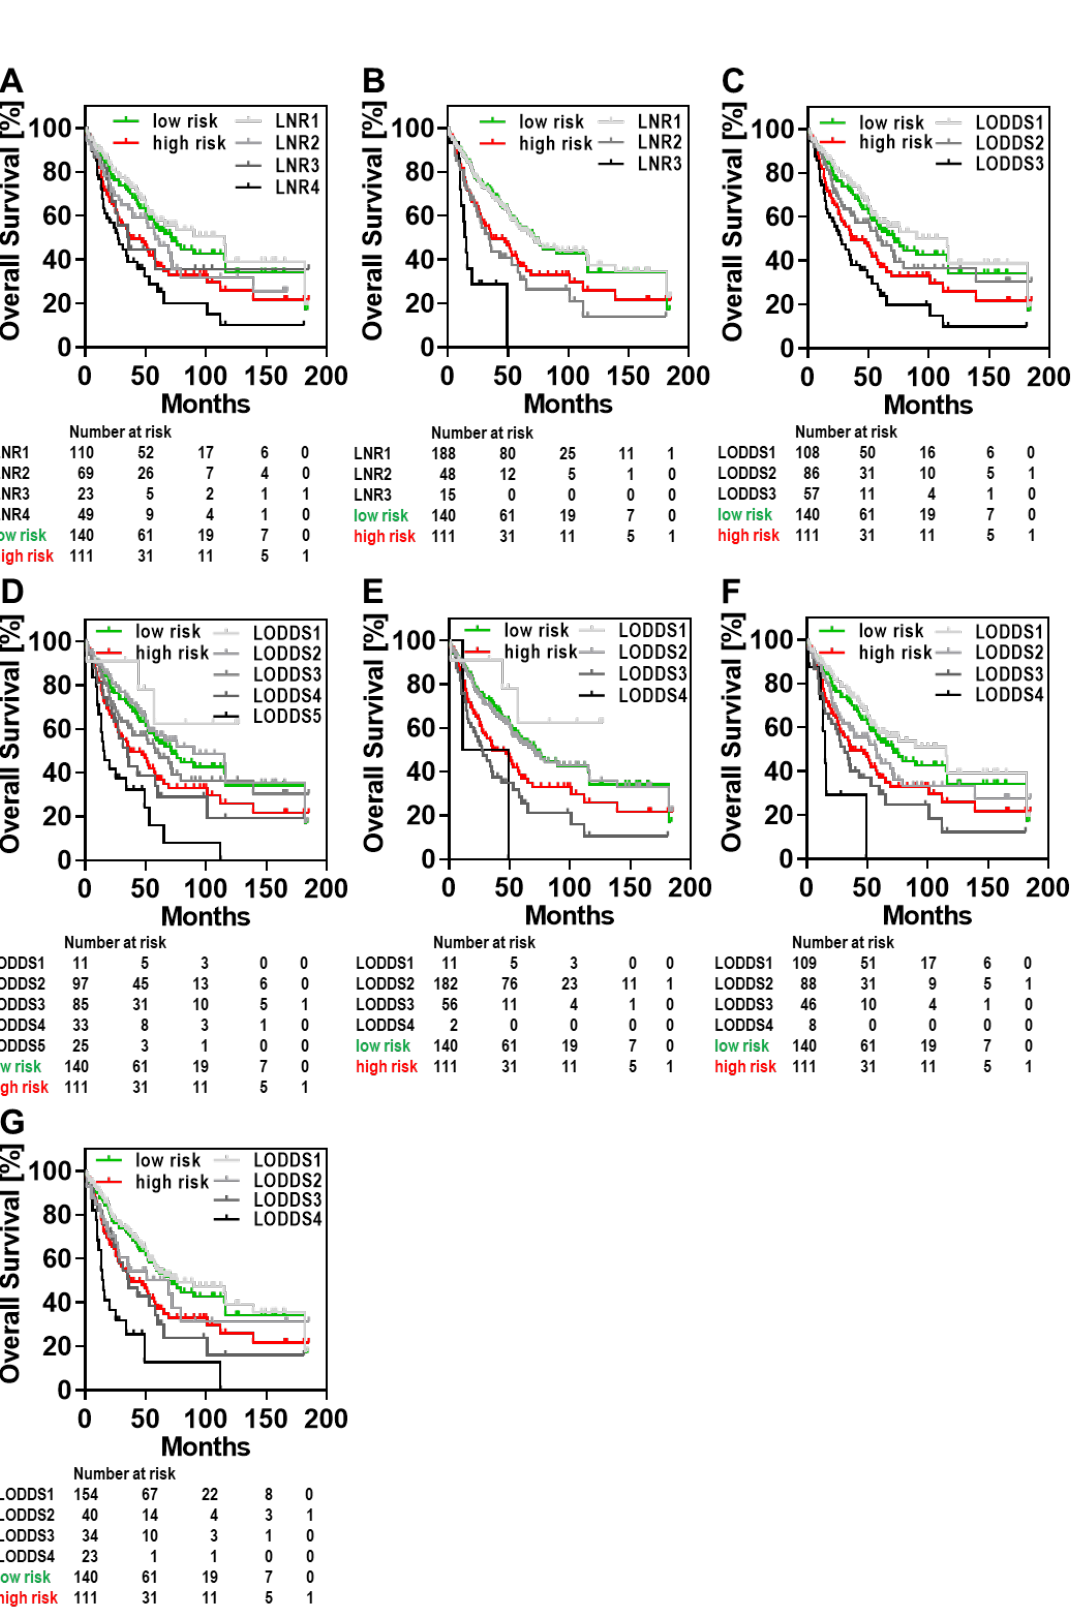
Figure 3. Kaplan–Meier survival curves for OS in UICC III CRC patients ( n = 251) depending on the LNR classification system proposed by ( A ) Lee et al. [21], ( B ) Fortea-Sanchis et al. [2] or the LODDS classification system suggested by ( C ) Fortea-Sanchis et al. [2], ( D ) He et al. [35], ( E ) Calero et al. [20], ( F ) Bagante et al. [23] and ( G ) Jian-Hui et al. [24]. Red and green OS curves indicate high risk (T4, N2 or both) and low risk (T1, T2, or T3 and N1) patients, respectively.